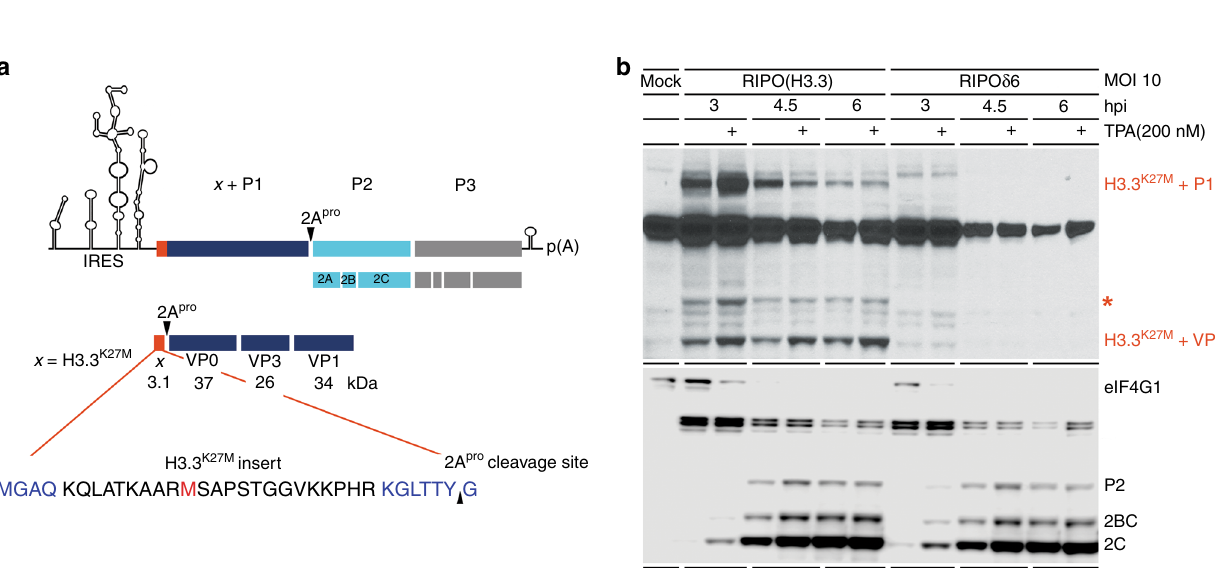
Fig. 2 RIPO(H3.3) expresses and processes the foreign H3.3 K27M antigen. a Processing map for RIPO(H3.3); the H3.3 K27M epitope is shown in red. b Top panel. Viral P1 and VP0 precursor polypeptides fused to the H3.3 K27M epitope were detected. We observed an additional, weaker band in RIPO (H3.3)-infected cells that cannot be assigned to any of the predicted viral precursor polypeptides in size (*). Since the signal strength of this band over time recapitulated the pattern of H3.3 K27M -P1, we assume that this band represents a degradation product of H3.3 K27M -P1. Bottom Panel. eIF4G1 cleavage, viral P2/2BC/2C expression in HeLa cells infected with RIPO(H3.3). 12-O-Tetradecanoylphorbol-13-acetate (TPA) was used to stimulate viral translation 64